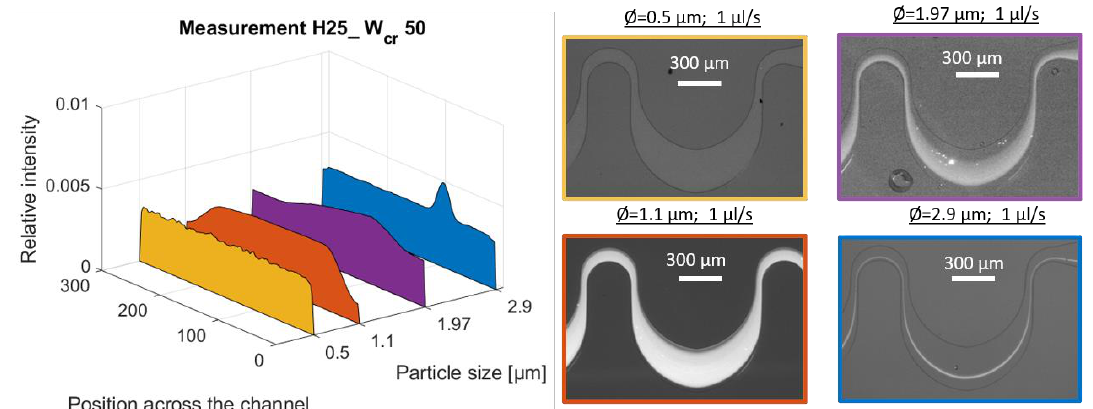
Figure 4. The size limit of lateral focusing in channel H25_W cr 50 at 1µL/s. The applied bead sizes are Ø = 0.5, 1.1, 1.97 and 2.9 µm.